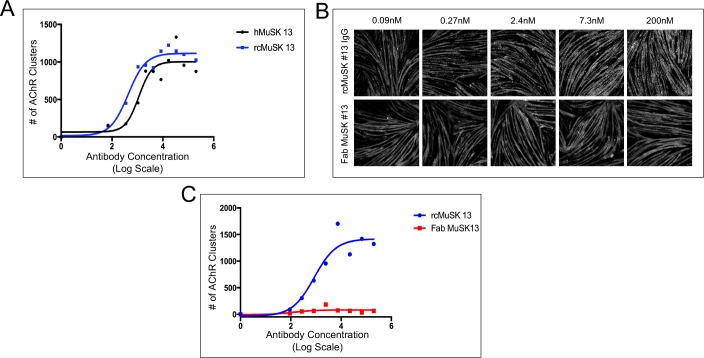
The human and reverse chimera versions of MuSK agonist antibody #13 induce acetylcholine receptor (AChR) clustering in C2C12 myotubes whereas a Fab from MuSK antibody #13 fails to stimulate AChR clustering.(A) Human (h) and reverse chimera (rc) MuSK #13 antibodies are similarly effective in stimulating AChR clustering in C2C12 myotubes (n = 3). (B,C) C2C12 myotubes were treated with rc MuSK #13 or a Fab from MuSK #13 for 16 hr at the indicated concentrations and stained with α-BGT. We found that the Fab fragment from antibody #13, unlike the intact IgG or the scFv, was unable to stimulate clustering of AChRs, indicating that antibodies must be dimeric and force-dimerize MuSK and promote an orientation that is favorable for trans-phosphorylation. (C) The rc antibody #13 stimulates AChR clustering in a dose-dependent and saturable manner, whereas Fab #13 fails to stimulate AChR clustering (n = 3).